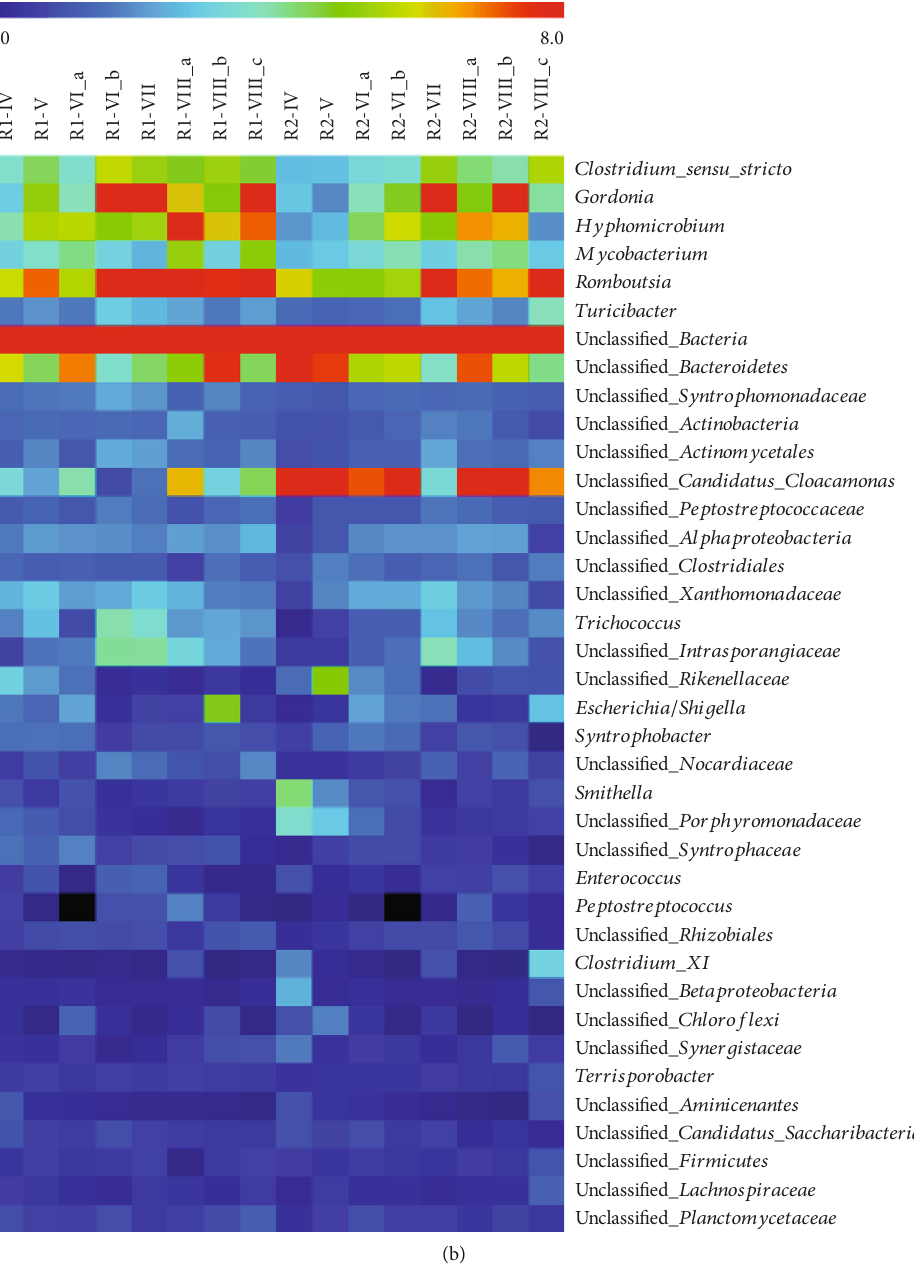
Figure 4: (a) Relative abundance of the bacterial phyla of two parallel reactors at several sampling points. (b) Heat maps of relative abundance ( > 1%) of the most abundant bacterial ASVs of R1 and R2. The scale limit starts from 0 (abundance equal to 1% because of the selection) to 8%. Increasing red colour indicates a higher value of relative species abundance, and blue colour indicates a lower relative